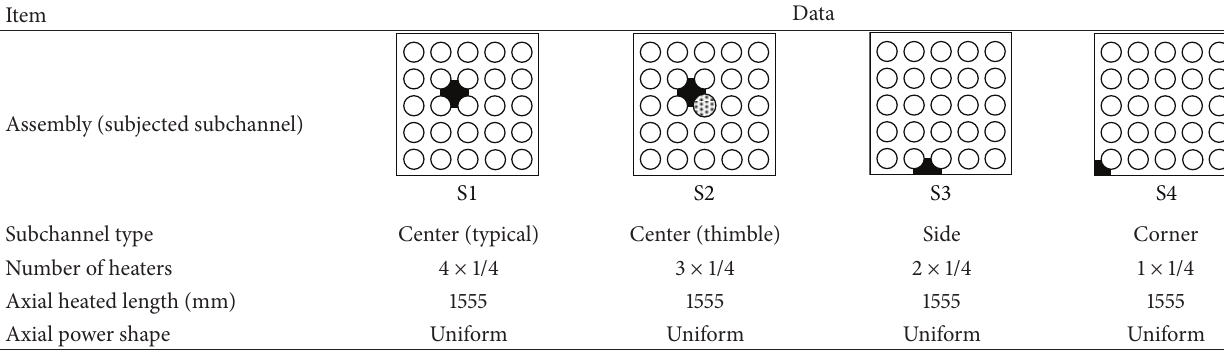
Table 3: Geometry and power shape for subchannel test assemblies for void distribution benchmark.